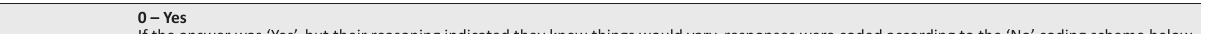
TABLE 3: Codes for Question 2: Reasons for expectations in repeated trials. Answer